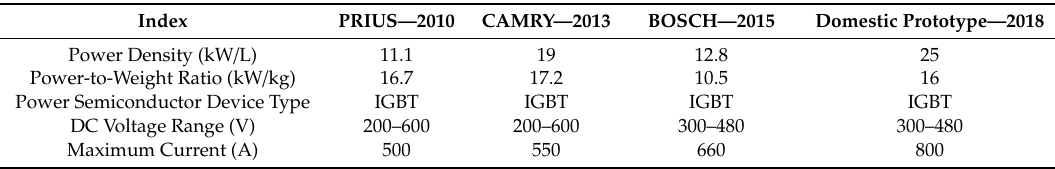
Table 2. The technical index changes of the traction motor controller from 2010 to 2018.